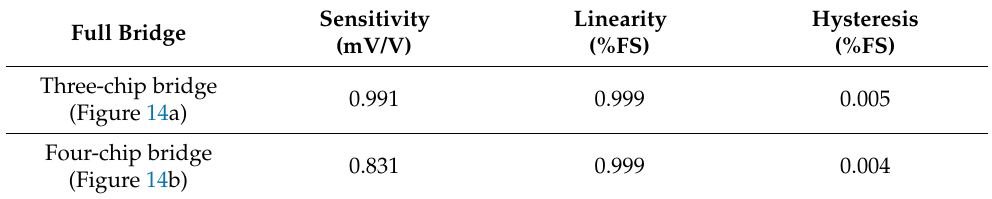
Table 3. Comparison of output characteristics of a three-chip bridge and a four-chip bridge.